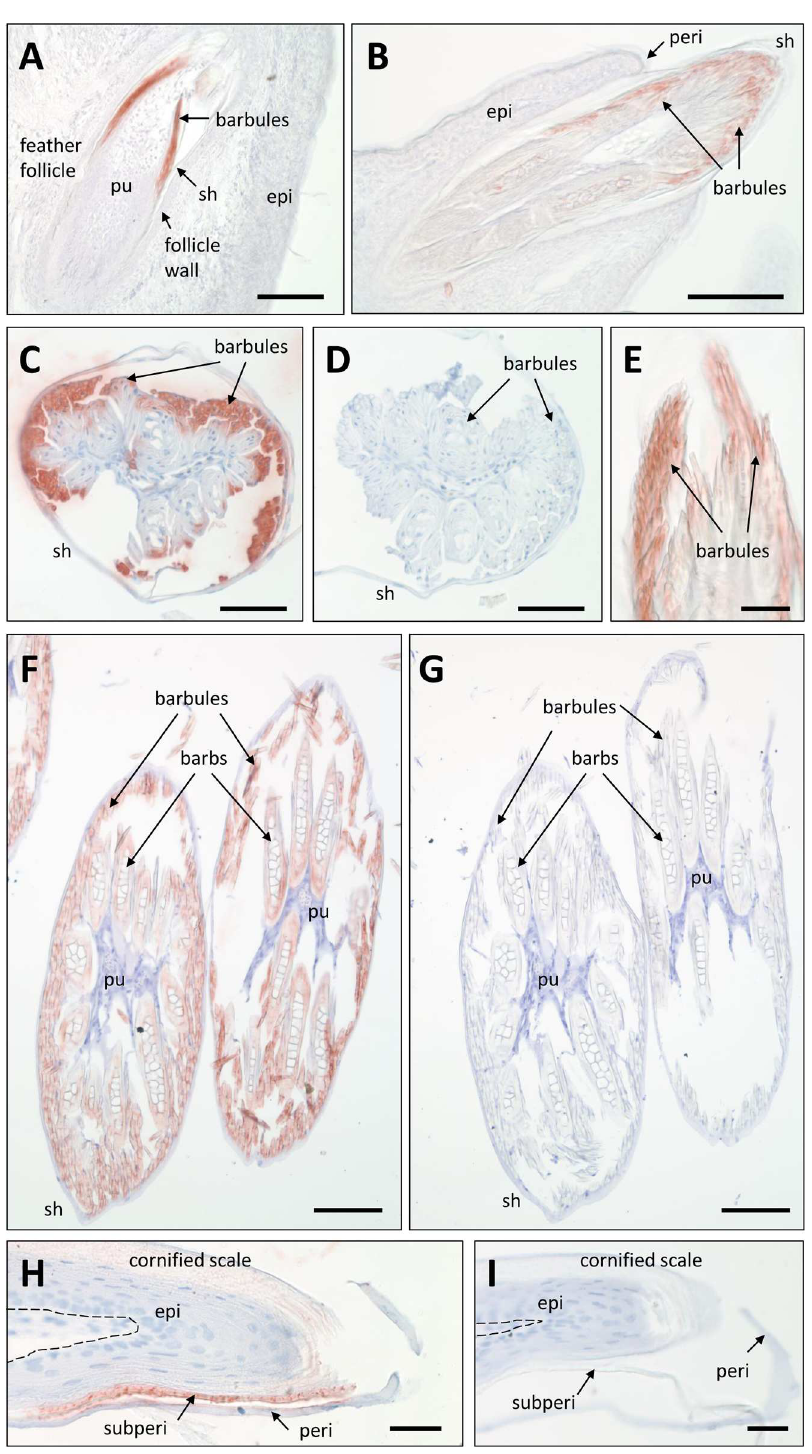
Fig 3. Light microscopic immunohistochemistry of EDMTFH. ( A-C , E, F ) Feather folliclesand feathers on the wings of chick embryos on day E18 of development were immunostained with anti-EDMTFH (red). In negativecontrol experiments the primary antibodywas replacedwith an antiserumraised againstan unrelatedpeptide( D ) or preabsorbedwith the antigen( G ). Scutate scales on the legs of chick embryos (day E19) were immunolabeledfor EDMTFH ( H ) or subjectedto the negativecontrol experiment ( I ). The dermo- epidermal junction is indicatedby a dashedline ( H , I ). epi, epidermis; peri, periderm; pu, pulp; sh, feather sheath; subperi, subperiderm. Bars: 100 μ m ( A , B , F , G ), 50 μ m ( C - E ), 25 μ m ( H , I ).